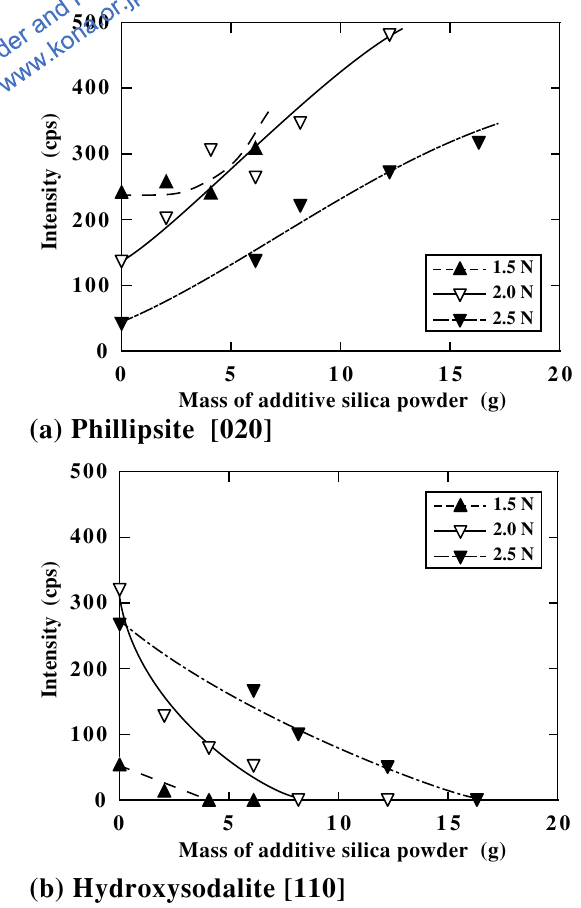
Fig. 10 XRD peak intensity of products as a function of additive silica mass for various NaOHaq. concentrations (Treatment time = 12hr, Fly ash + Silica powder = 40.0g).